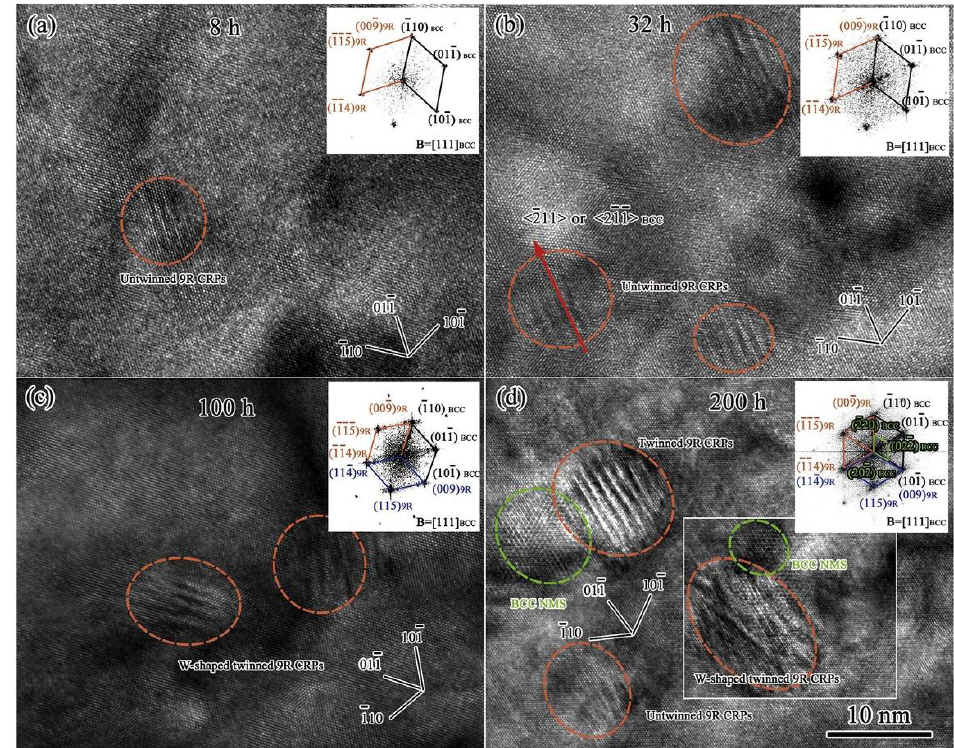
Figure 7. HRTEM micrograph and insert FFT results of precipitates taken along [ 111 ] α − Fe during aging: ( a ) Only one Cu-rich precipitate with un-twinned 9R structure after aging for 8 h; ( b ) three un-twinned 9R Cu-rich precipitates treated for 32 h; ( c ) W-shaped twinned 9R Cu-rich precipitates aging for 100 h; ( d ) precipitates co-precipitated with twinned and W-shaped twinned 9R Cu-rich precipitates for 200 h [88]. (Reprinted with permission from Ref. [88]. Copyright 2018 Elsevier).